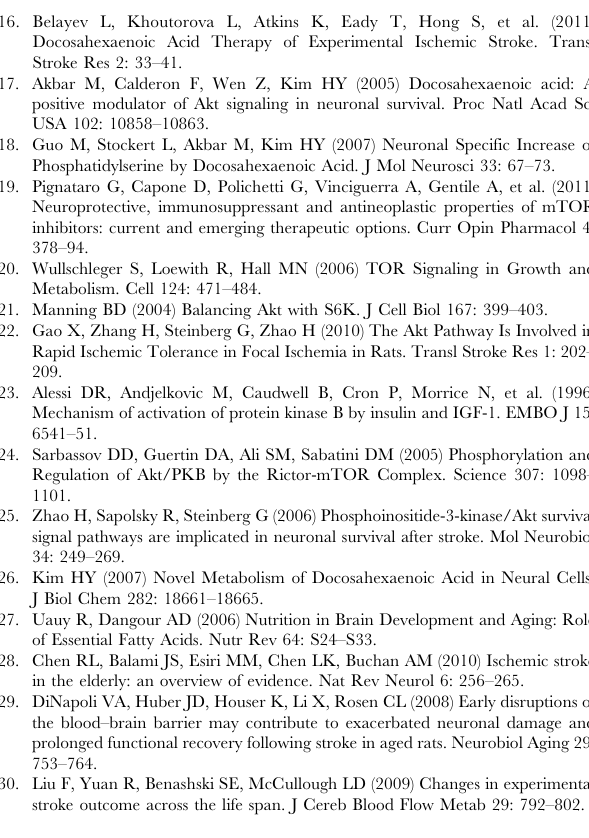
Figure 6. Protein phosphorylation in aged animals. Panel A: Schematic coronal brain diagram showing locations of regions of interest for Western blot analysis in the penumbra (regions 6, 7, and 8). Individual regions of the penumbra (6, 7, 8) were analyzed separately and also pooled together for Panel B. Treatment with NPD1 or DHA did not resulted in significantly different expression of phosphorylated p308 AKT or pGSK (ser9) over saline but resulted in higher levels of S6 (ser235) phosphorylation at 4 h when compared to saline-treated aged animals. Panel C: Representative Western blots of AKT p308, pGSK and pS6 trials in aged animals. Data are mean 6 SEM. * indicates significant difference between groups (p , 0.05; repeated measures ANOVA followed by Bonferroni